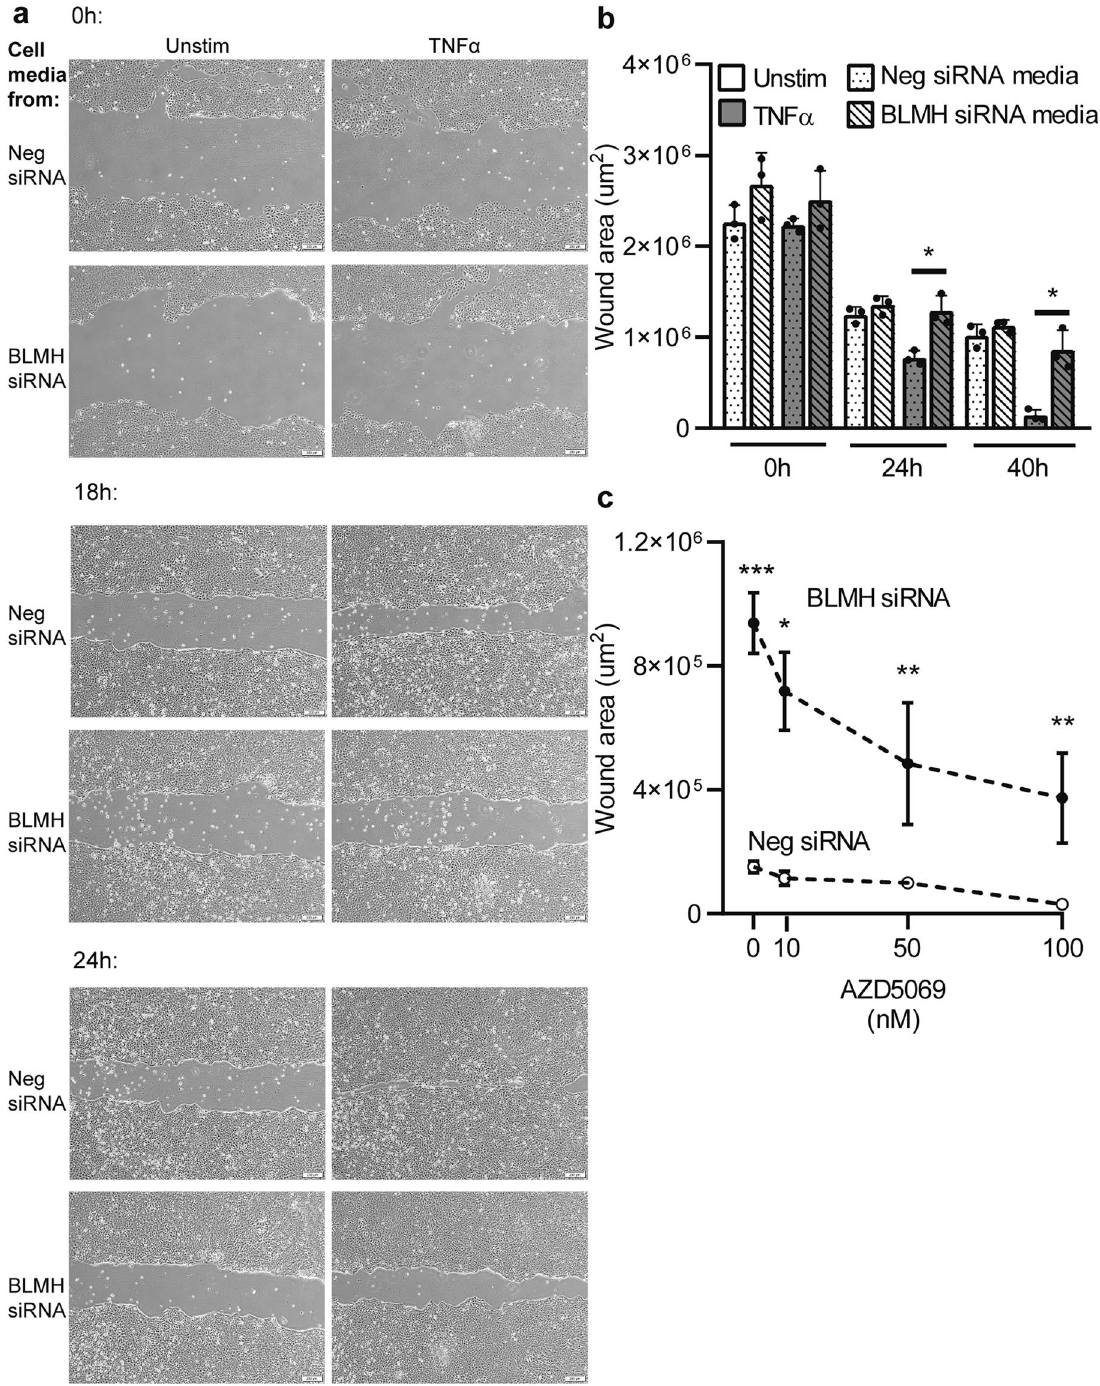
Figure 4. The impaired wound healing is caused by soluble mediators in cell supernatants from BLMH knock- down cells. ( a,b ) Untreated HaCaT cells were cultured into monolayers to approximately 80% confluency. A scratch wound was performed, and supernatants collected from BLMH knock-down cells were added, diluted 1:1 in fresh culture media. The wound areas were analysed after 18 and 24 hours of incubation, showed as representative images ( a ) and as wound area measurements ( b )(n = 3, paired two-tailed Student’s t-tests). In graph c , a specific CXCR2 receptor antagonist was added together with the supernatants at different concentrations and after 30 hours the wound area was determined (n = 4, paired two-tailed Student’s t-tests). All values represent individual experiments with mean ± standard deviation. Significant P-values are presented as * p < 0.05; ** p < 0.01; *** p < 0.001 and **** p <